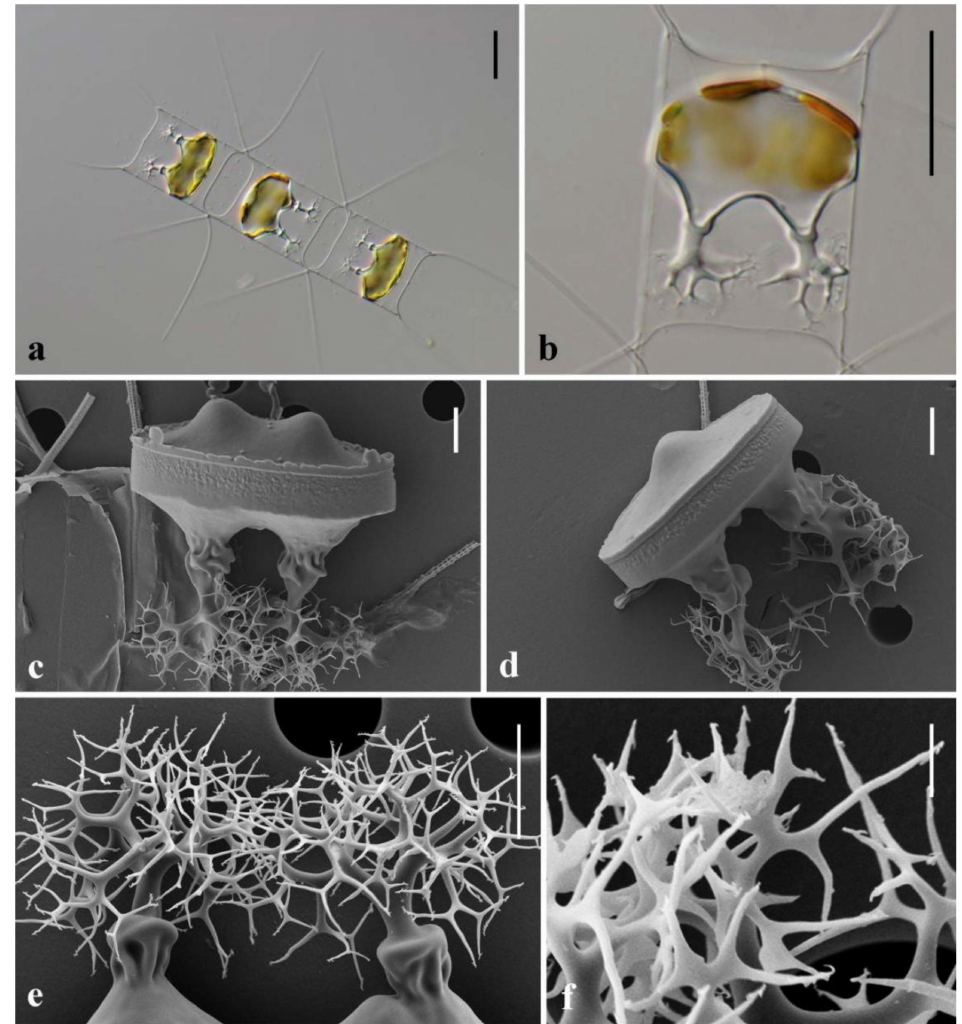
Figure 5. LM ( a , b ) and SEM ( c – f ) micrographs of resting spores of Chaetoceros densoelegans sp. nov., strain MC687. ( a , b ) Resting spores within mother cells of a chain; ( c , d ) released resting spores, showing two elongated elevations with dichotomous branching processes distally on the primary valve face and one ( d ) or two bulges ( c ) on the secondary valve face; ( e ) dichotomous branching processes; ( f ) hooks on the distal tips. Scale bars: ( a , b ) 20 µ m; ( c – e ) 5 µ m; 1 µ m ( f